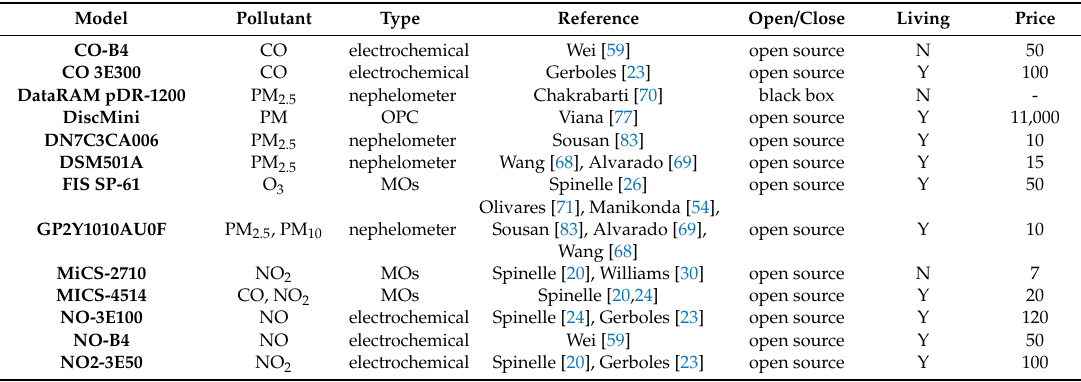
Table A2. Model of OEMs by pollutant, type, openness, and